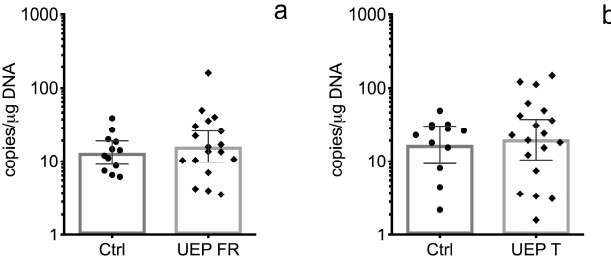
Figure 1. Representation of data from the brain tissue analysis: ( a ) Copies of B19V VP1 genomic sequence in the frontal lobes of control (Ctrl) and unspecified encephalopathy (UEP) groups; ( b ) Copies of B19V VP1 genomic sequence in the temporal lobes of control (Ctrl) and UEP groups. Scatter plots with bar represent geometric mean ± 95% CI.